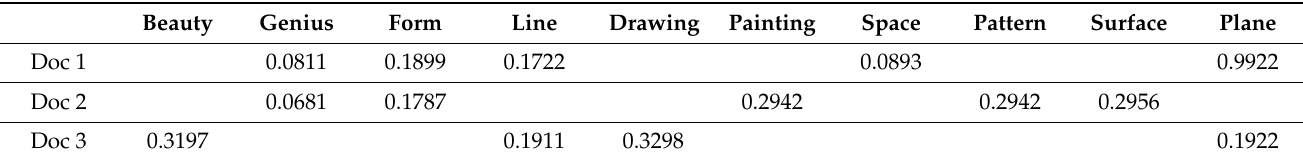
Table 1. Simplified representation of textual corpus